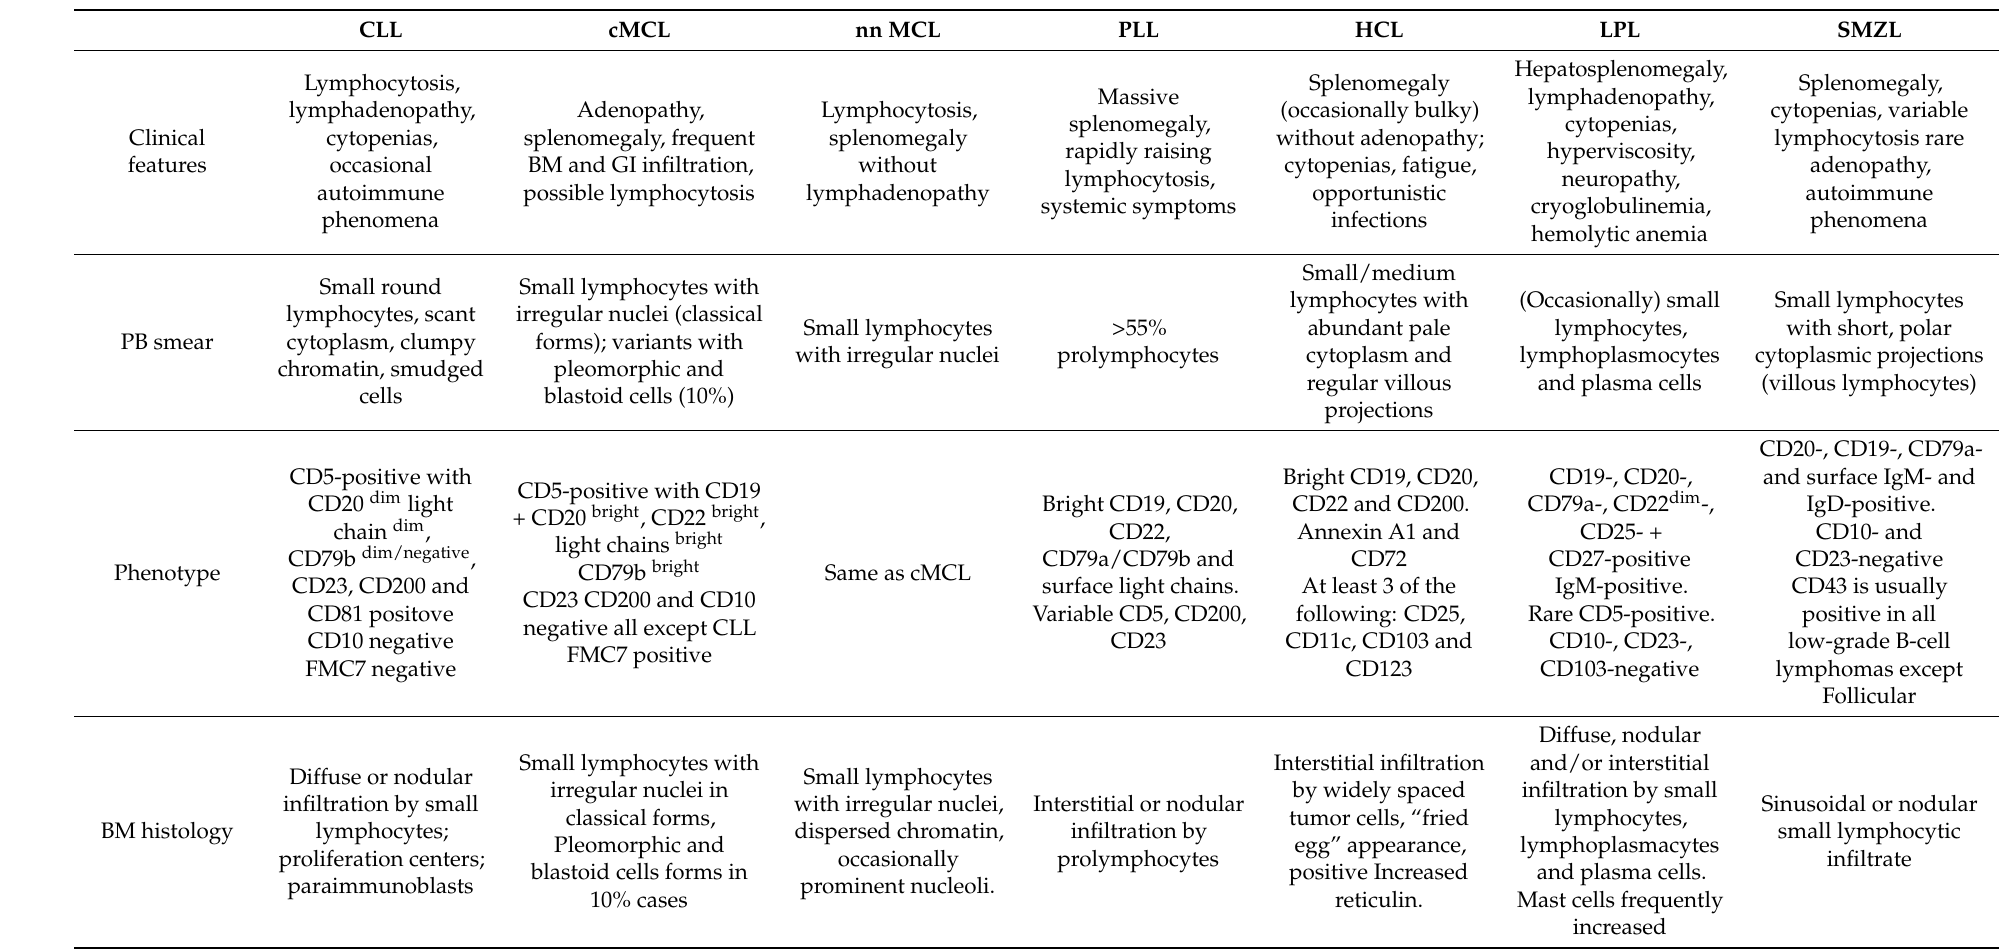
Table 1. Differential diagnosis of splenic CD5-positive indolent